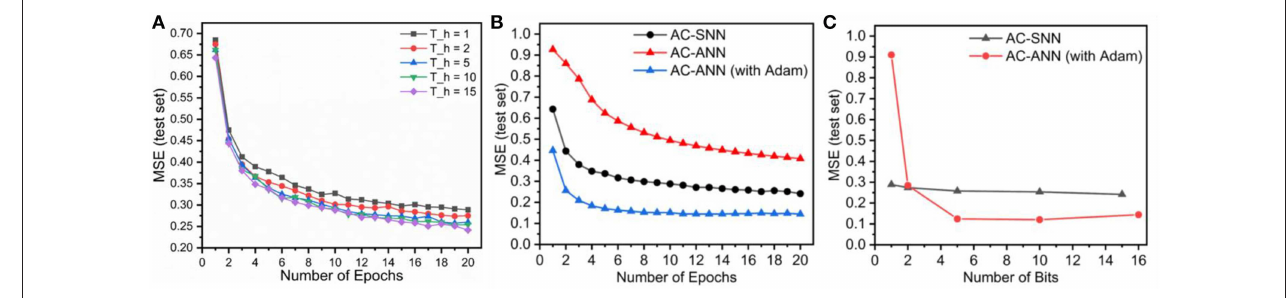
FIGURE 10 | The audiocoder (AC-SNN/AC-ANN) is trained over Dataset A, while the autoencoder (AE-SNN/AE-ANN) is fixed. MSE is reported on the overall audio-to-image synthesis model composed of AC-SNN/ANN and AE-SNN/ANN. (A) Reconstruction loss of the audio-to-image synthesis model for varying T h . (B)